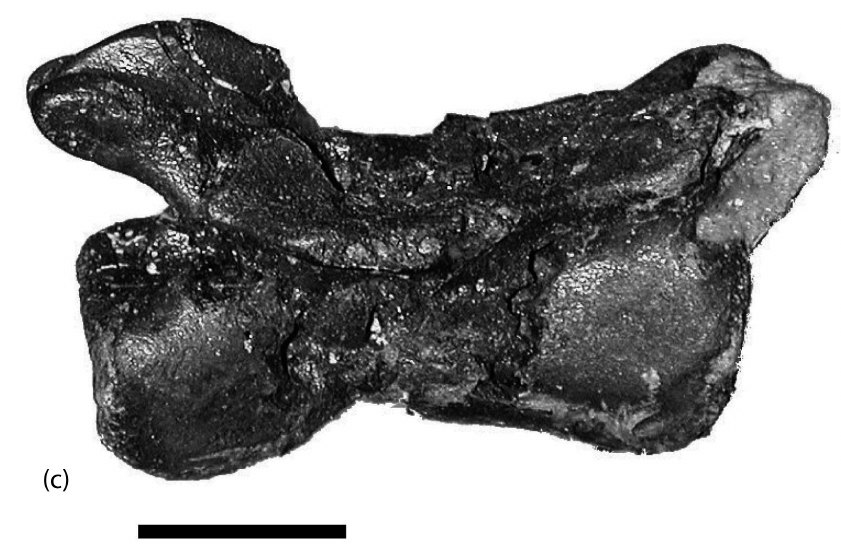
Figure 7. Theropod remains from the Valtos Sandstone Formation Isle of Skye, ( a ) tooth and; ( b ) expanded view of denticles (GLAHM 125390a) scale = 1 mm; ( c ) caudal vertebra (GLAHM 101240), scale = 1 cm.